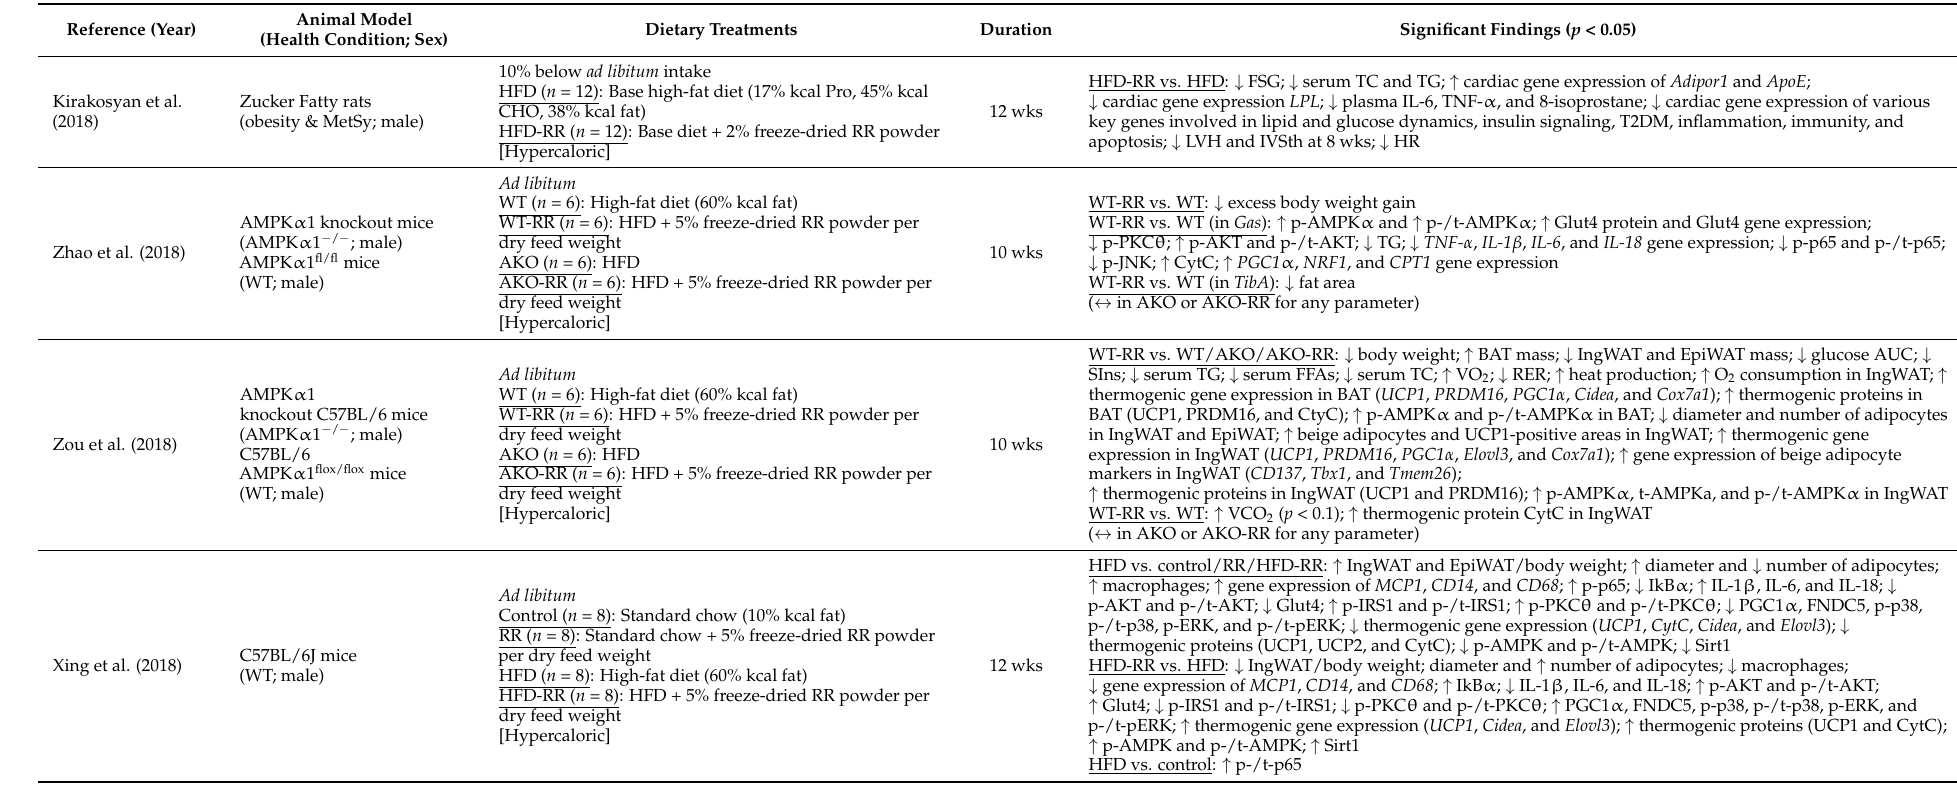
Table 2. Summary of animal studies investigating the effects of dietary whole red raspberries on metabolic